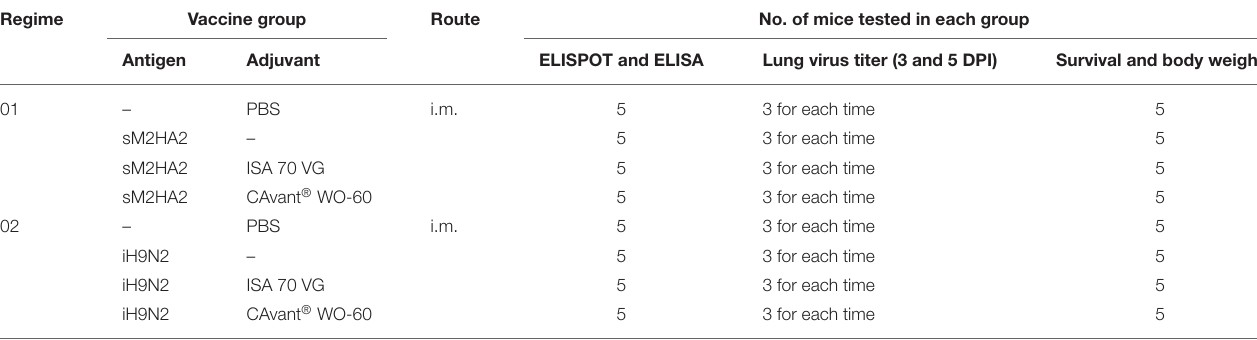
TABLE 1 | Groups for the mouse experiments. Regime Vaccine group Route No. of mice tested in each group